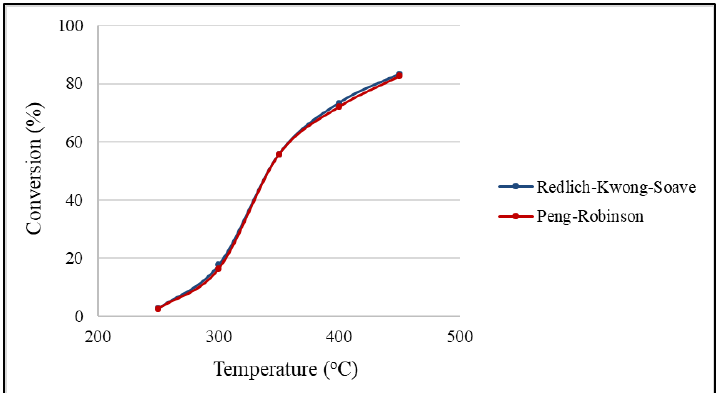
Figure 7. Effects of different equations of state. Reaction conditions: Temperature, 400 °C, pressure, 300 psig; gas phase, hydrogen; liquid phase, 4-propylguaiacol; liquid flow rate, 0.03 mL ∙ min −1 ; gas flow rate, 0.09 mL ∙ min −1 .